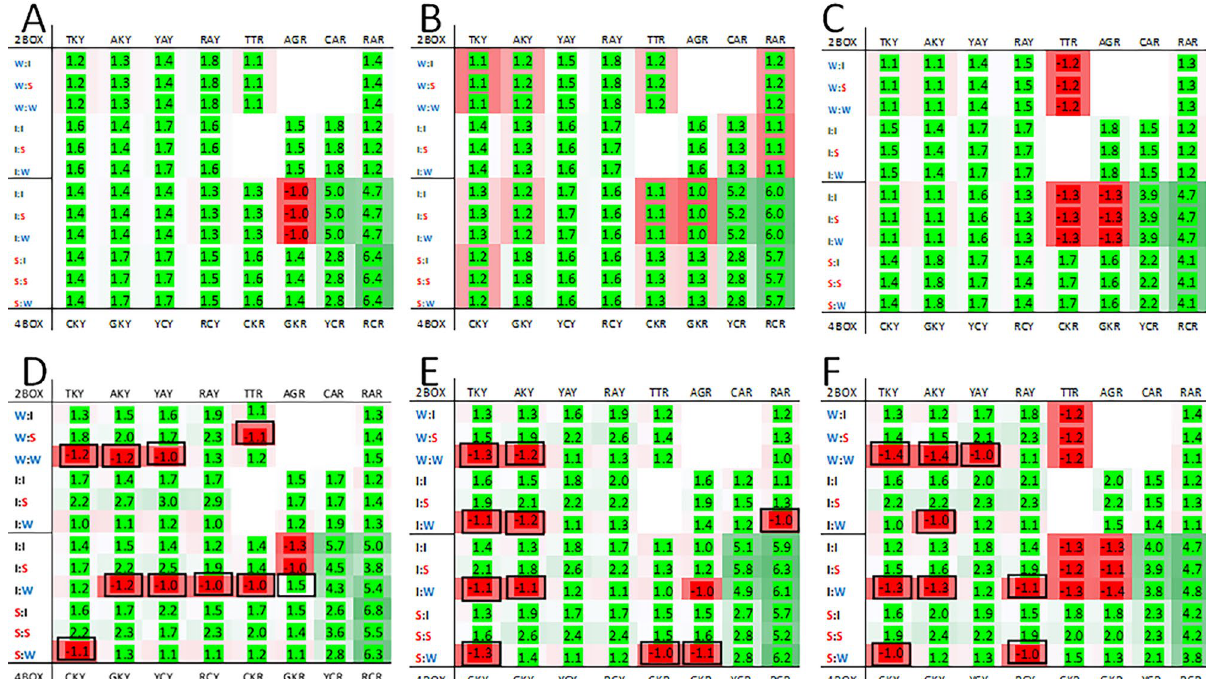
Figure 4. Heatmaps for Filoviridae ( A and D ), Paramyxoviridae ( B and E ), and Rhabdoviridae ( C and F ). Heatmaps for the expected X3 bias for codon pairs are shown in the top panels and heatmaps for the observed X3 bias for codon pairs are shown in the lower panels. Features of the heatmaps are described in the “Methods” section. Black boxes indicate cells with biases opposite of the expected and with a frequency greater than 1.05 for either observed or expected ratio.